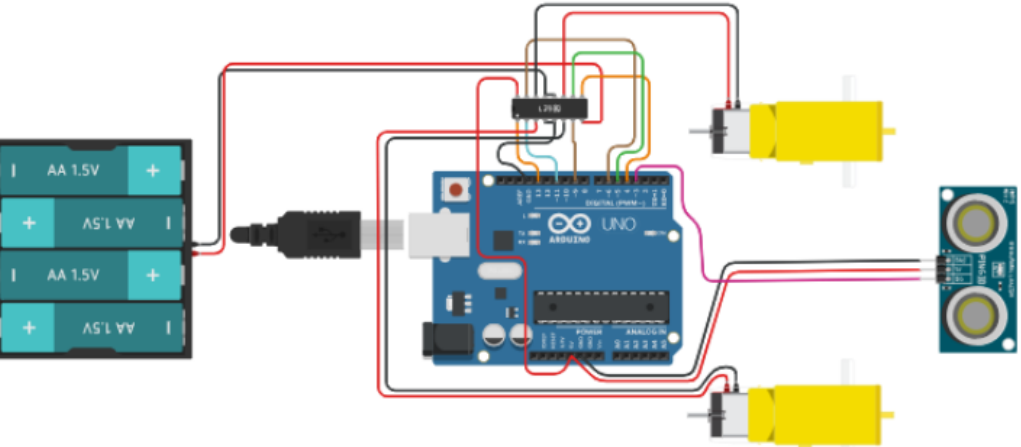
Figure 19. Structure of a Sensor on the Robot